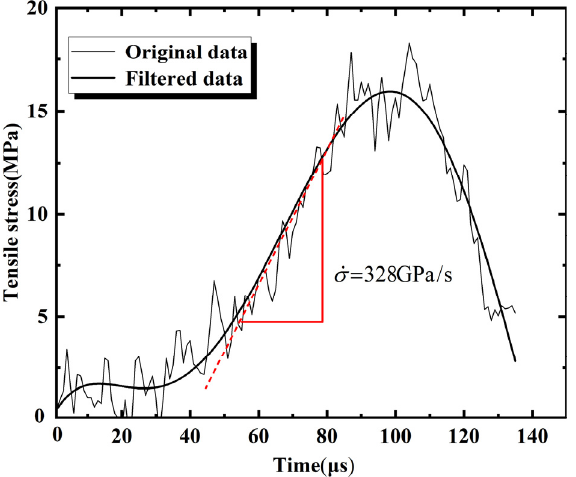
Figure 13. Calculation of the loading rate.